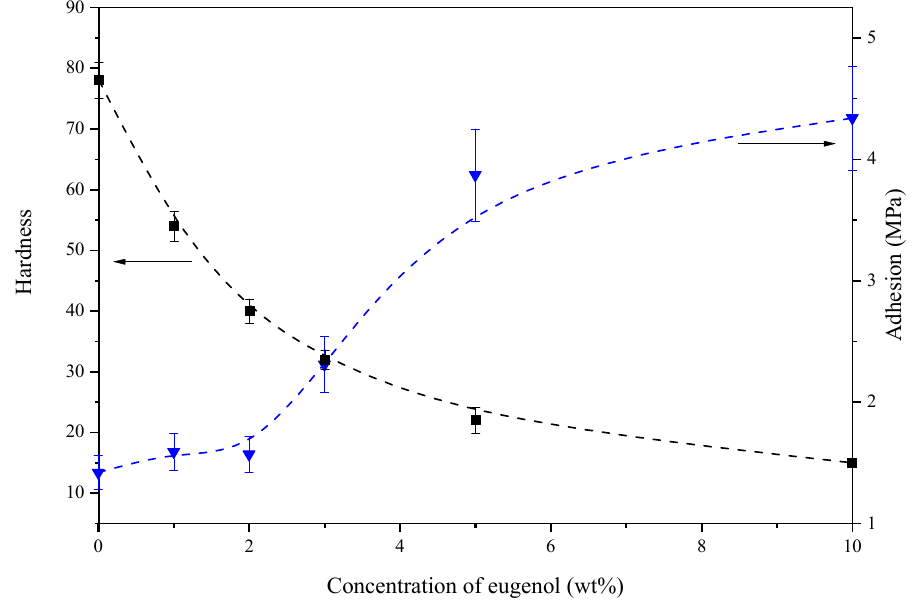
Figure 4. Pendulum hardness and adhesion of obtained UA coatings depending on eugenol con- centration.